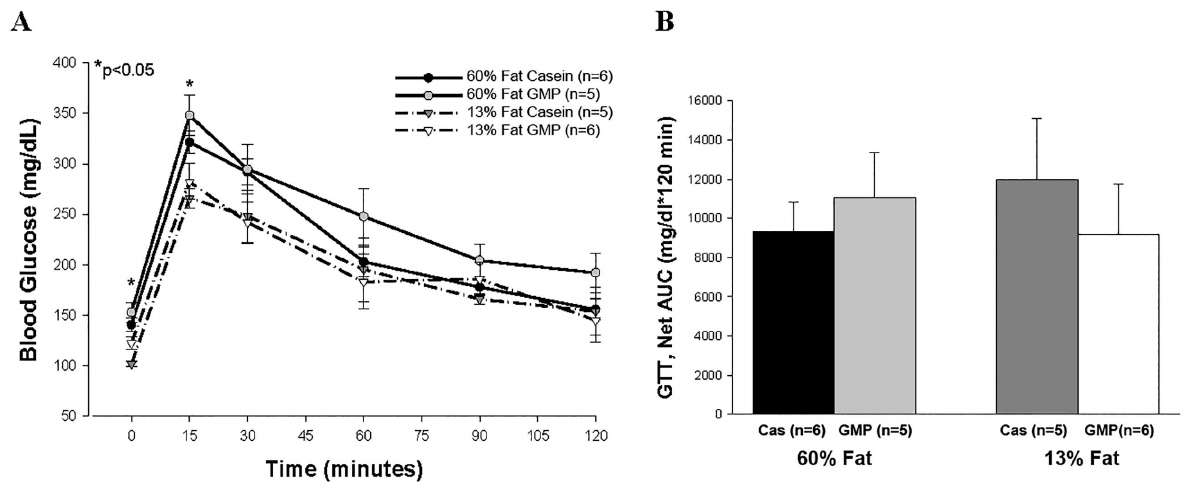
Fig 3. Glucose tolerance test. Glucose tolerance tests were performed on female mice fed 60%-fat casein, 60%-fat GMP, 13%-fat casein, or 13%-fat GMP diets after ingestingthe diet for 27 weeks (A). Glucose was administered by oral gavage after an overnight fast (12h). B, net area under the curve (AUC) of the GTT displayedin A. The data are expressed as means ± SE. Nos. in parentheses indicate sample size. * , p < 0.05.